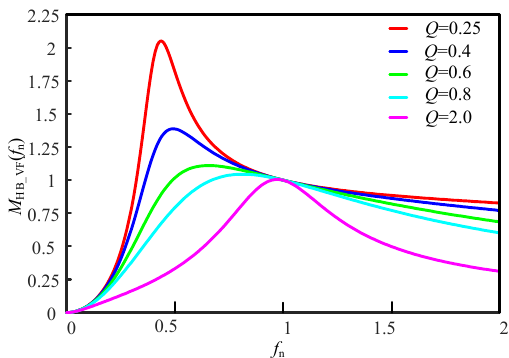
Figure 11. M FB_VF gain curve in full ‐ bridge FM mode.